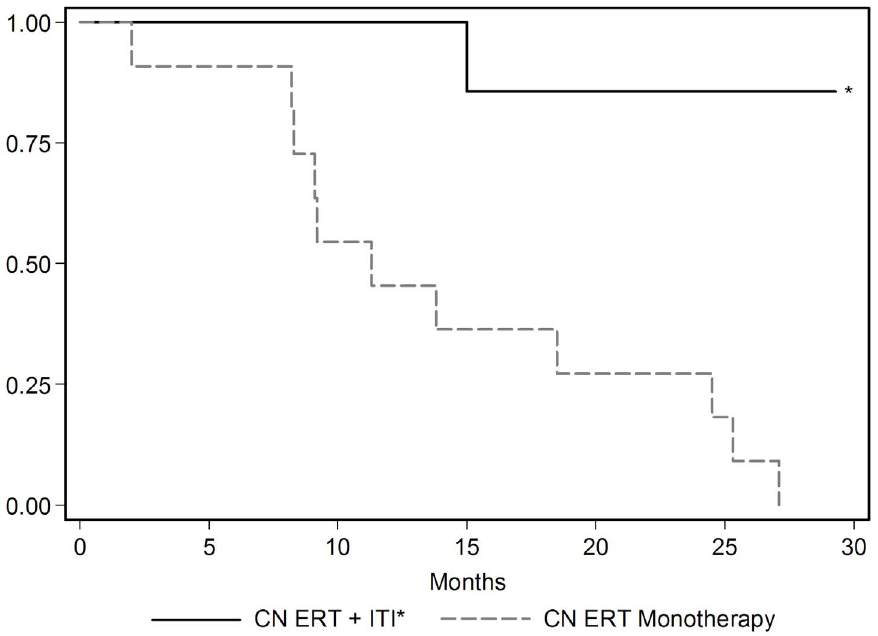
Figure 5. Kaplan-Meier survival curve showing comparison of ventilator-free survival CRIM-negative (CN) ERT monotherapy (n=11) versus CN ERT + ITI (n=7) treated patients. *Three patients in the CN ERT + ITI group began the study invasively ventilated, became ventilator-free with treatment, and are currently still alive and ventilator-free. In contrast, all CN patients in ERT monotherapy treated group were invasive ventilator-free at baseline. This observation suggests that in some cases ERT + ITI can even reverse ventilator dependence in CN Pompe patients.